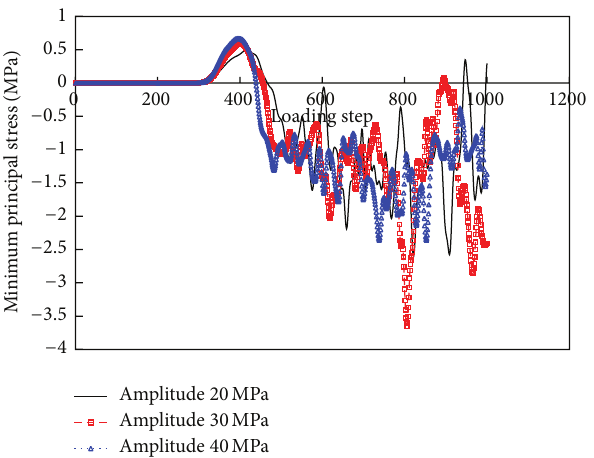
Figure 8: Accumulative damaged elements (AE) of sample in a different loading step ( 𝜎 max = 30 MPa).